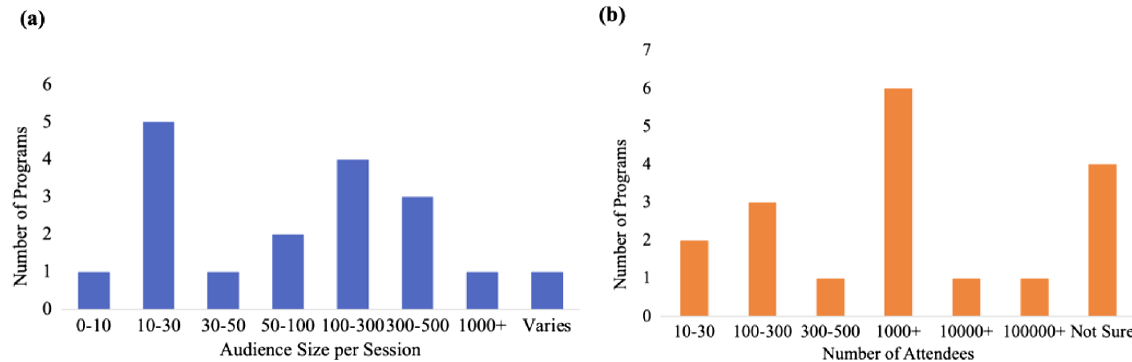
FIG. 10. (a) The distribution of the typical number of attendees per session in our sample. (b) The distribution of the audience size per year, including the repeat attendees for various activities and